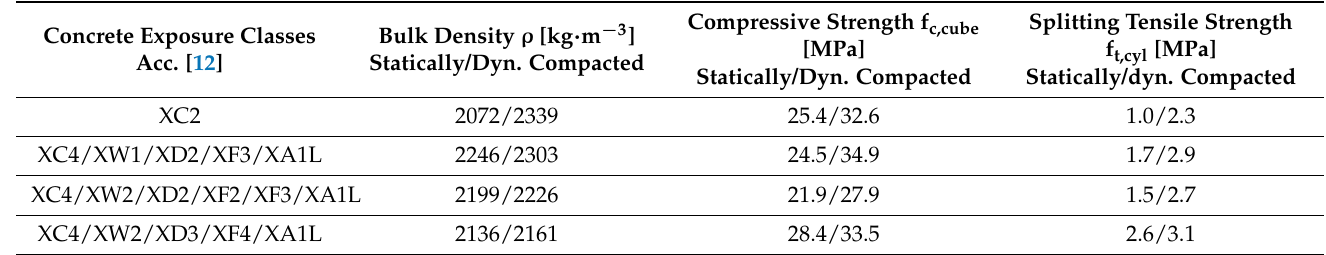
Table 2. Hardened concrete mortar properties of the laboratory-produced specimens (mean value from 3 tests in each case).